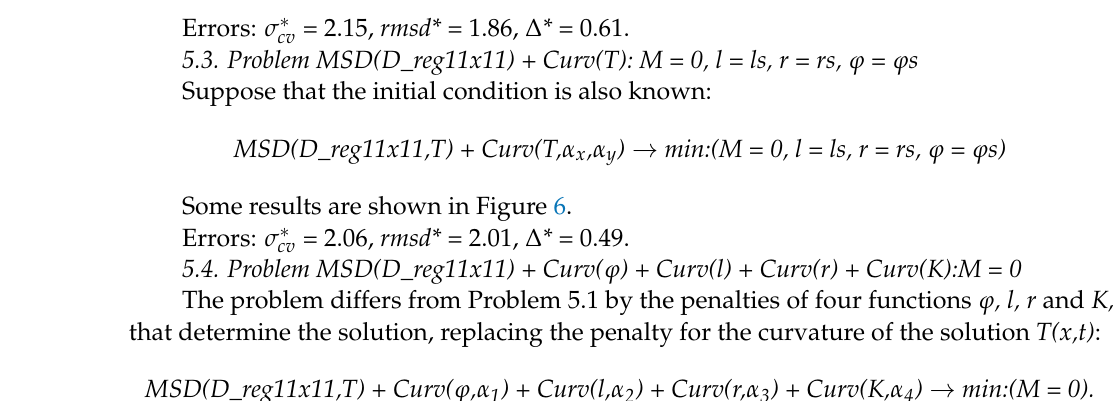
Figure 5. SvF solution of Problem 5.2: ( T ) contour lines of T(x,t) ; ( φ ) the initial condition; ( K ) the thermal conductivity coefficient K(t) .